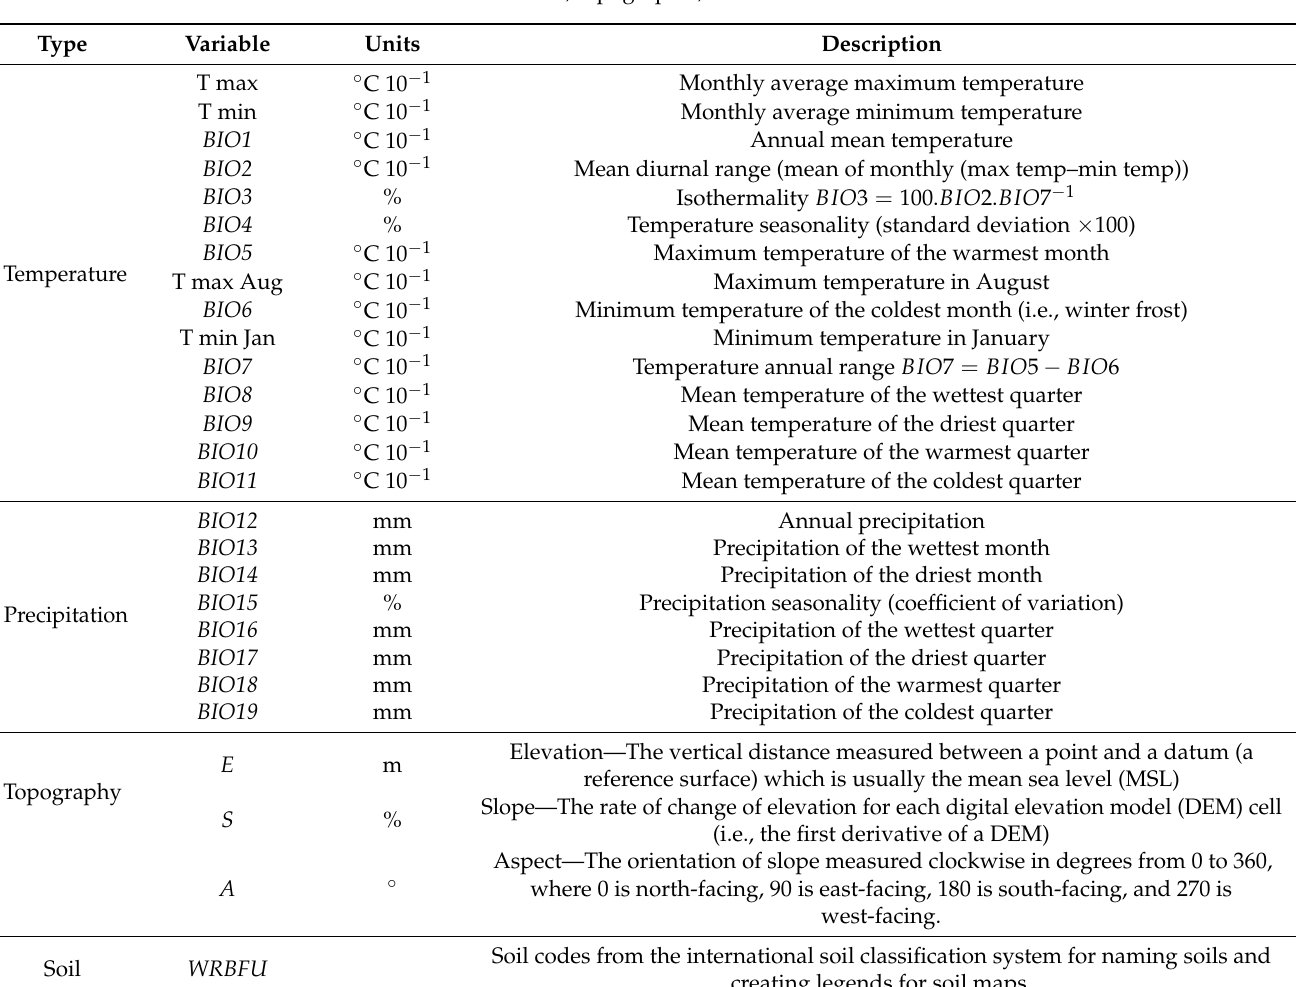
Table 1. Climatic, topographic, and soil